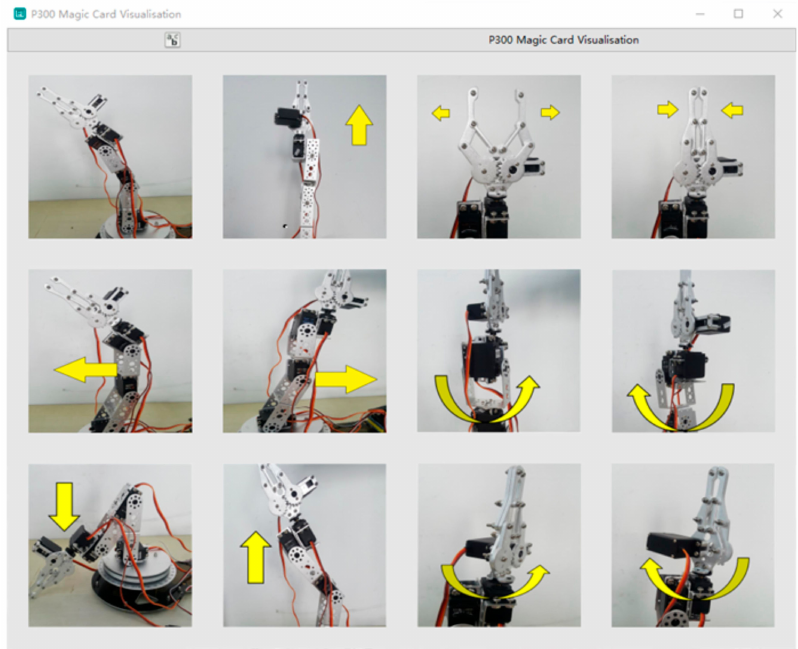
Figure 1. Stimuli